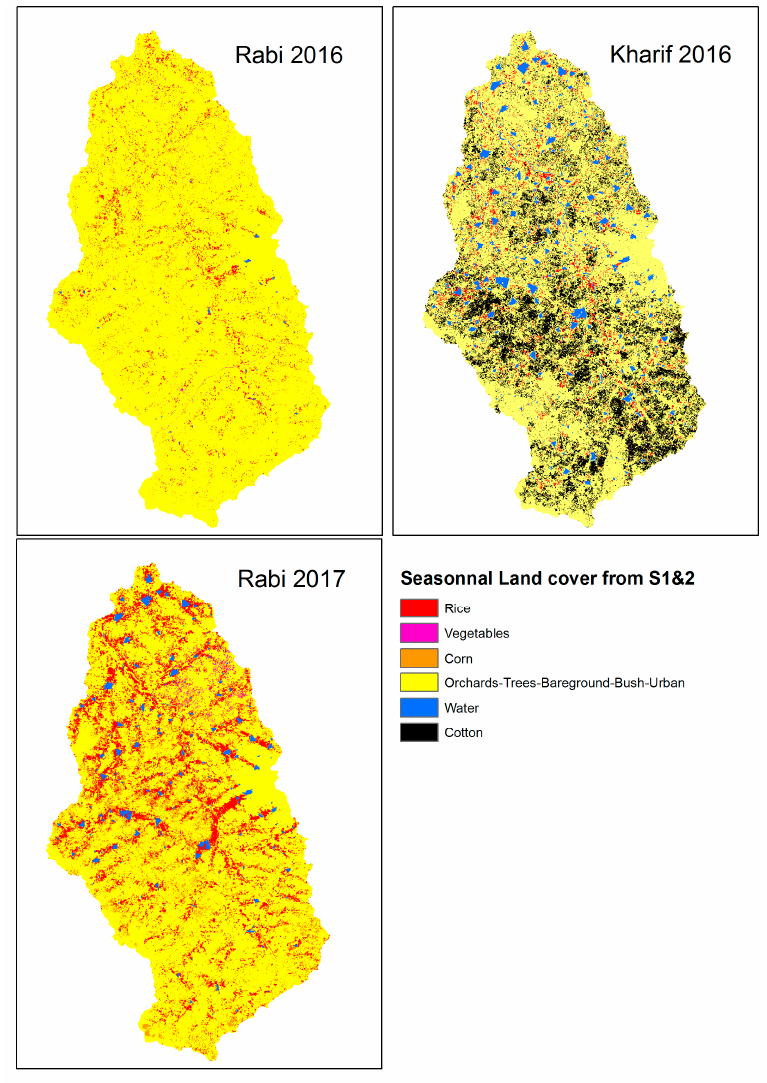
Figure 6. Rabi ( red dots ) and Kharif ( blue dots ) fractions of surface sown within the Kudaliar watershed since 2005. The black line data are published by the ISRO-NRSC in the framework of the NICES programs. The seasonal extents estimates from our study are in red crosses. They correspond to the addition of irrigated and non-irrigated crops areas.